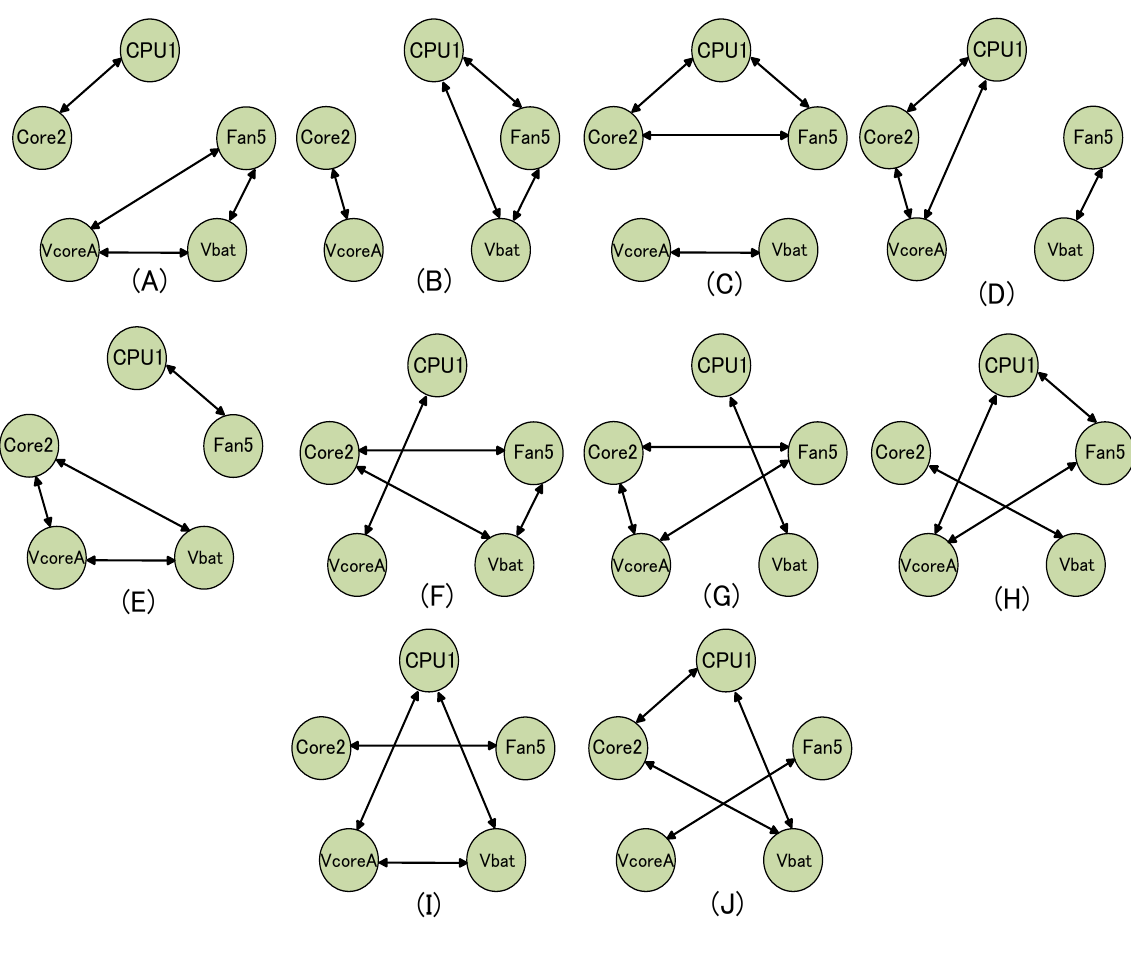
Table 9. Diagnostic accuracy of multiple